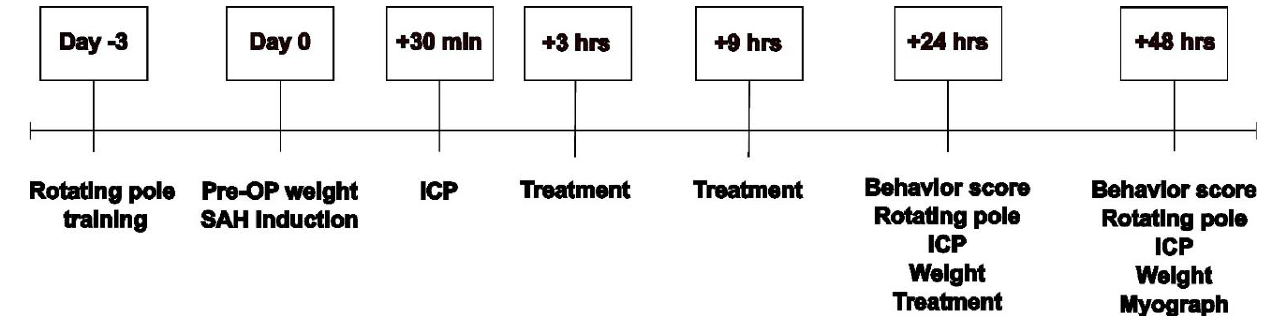
Figure 2. Study outline. Overview of the procedures and analysis performed for the current study. All timepoints relate to time 0, which is the induction of the SAH.